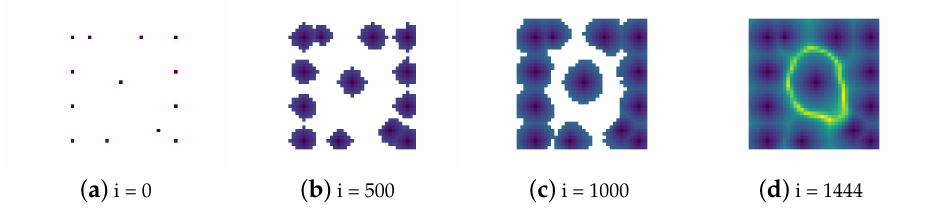
Figure 4. Evolution of the times matrix ( T ).